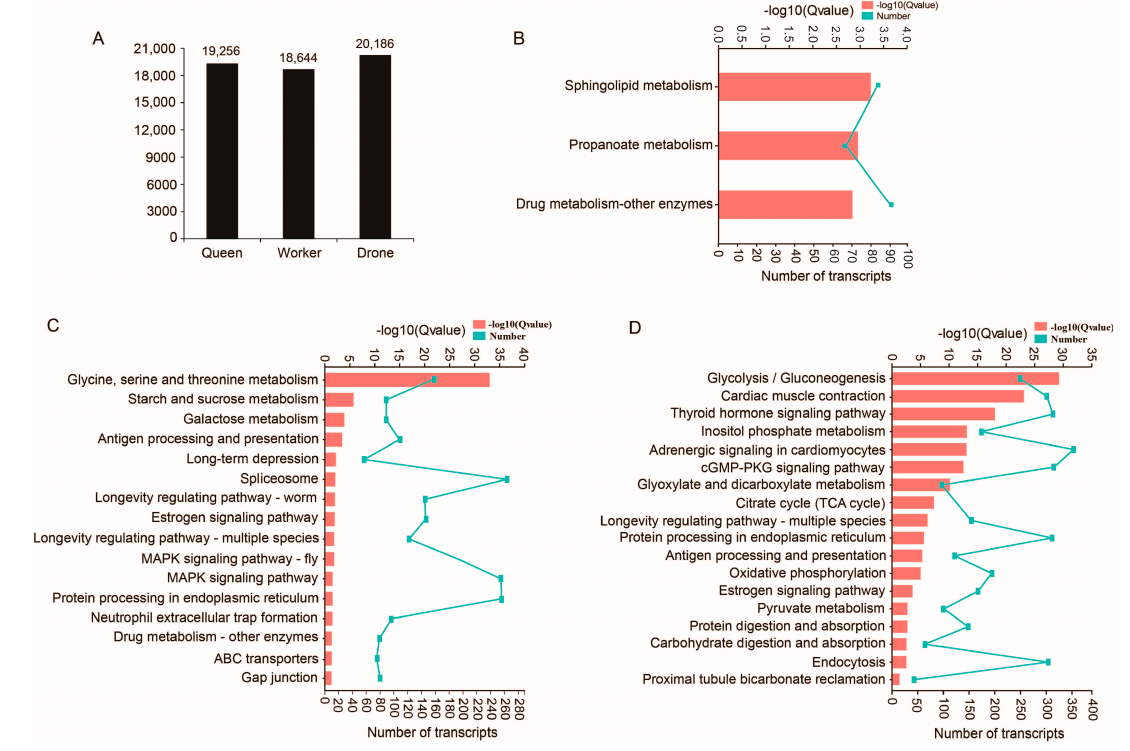
Figure 2. Unique transcripts isolated from queen, worker and drone datasets. ( A ) Numbers of unique transcripts in queen, worker and drone datasets. ( B – D ) show the significantly enriched KEGG pathways for queen-, worker- and drone-unique transcripts, respectively.